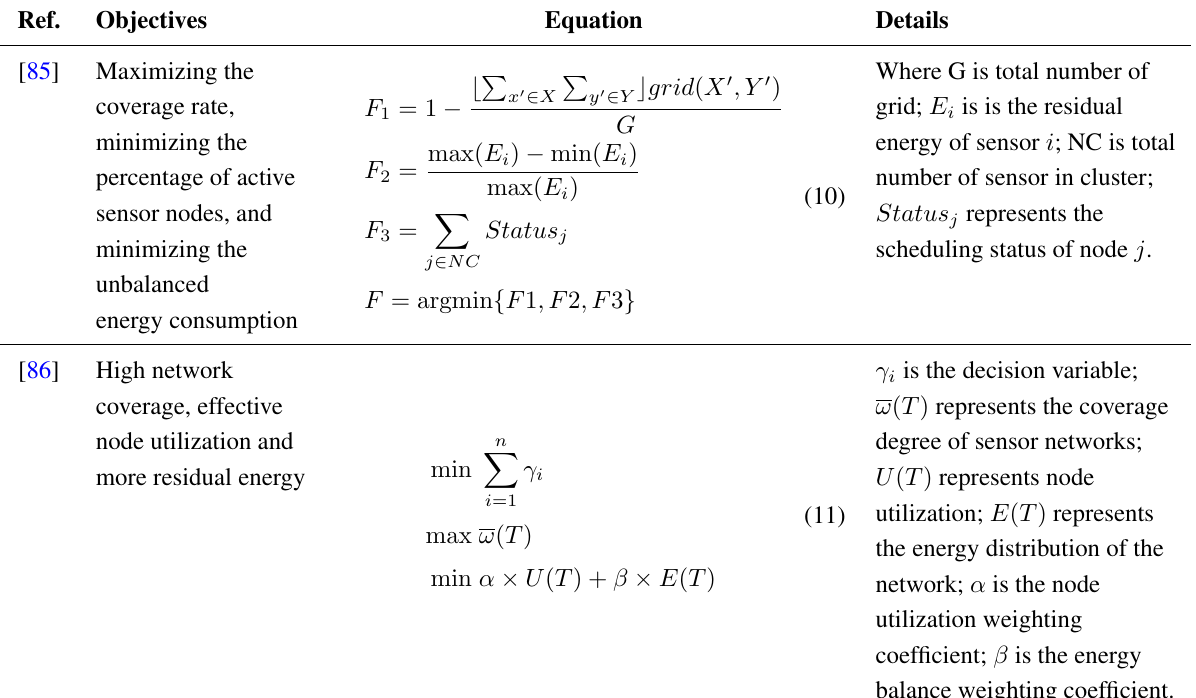
Table 3. Operation related objectives in wireless sensor